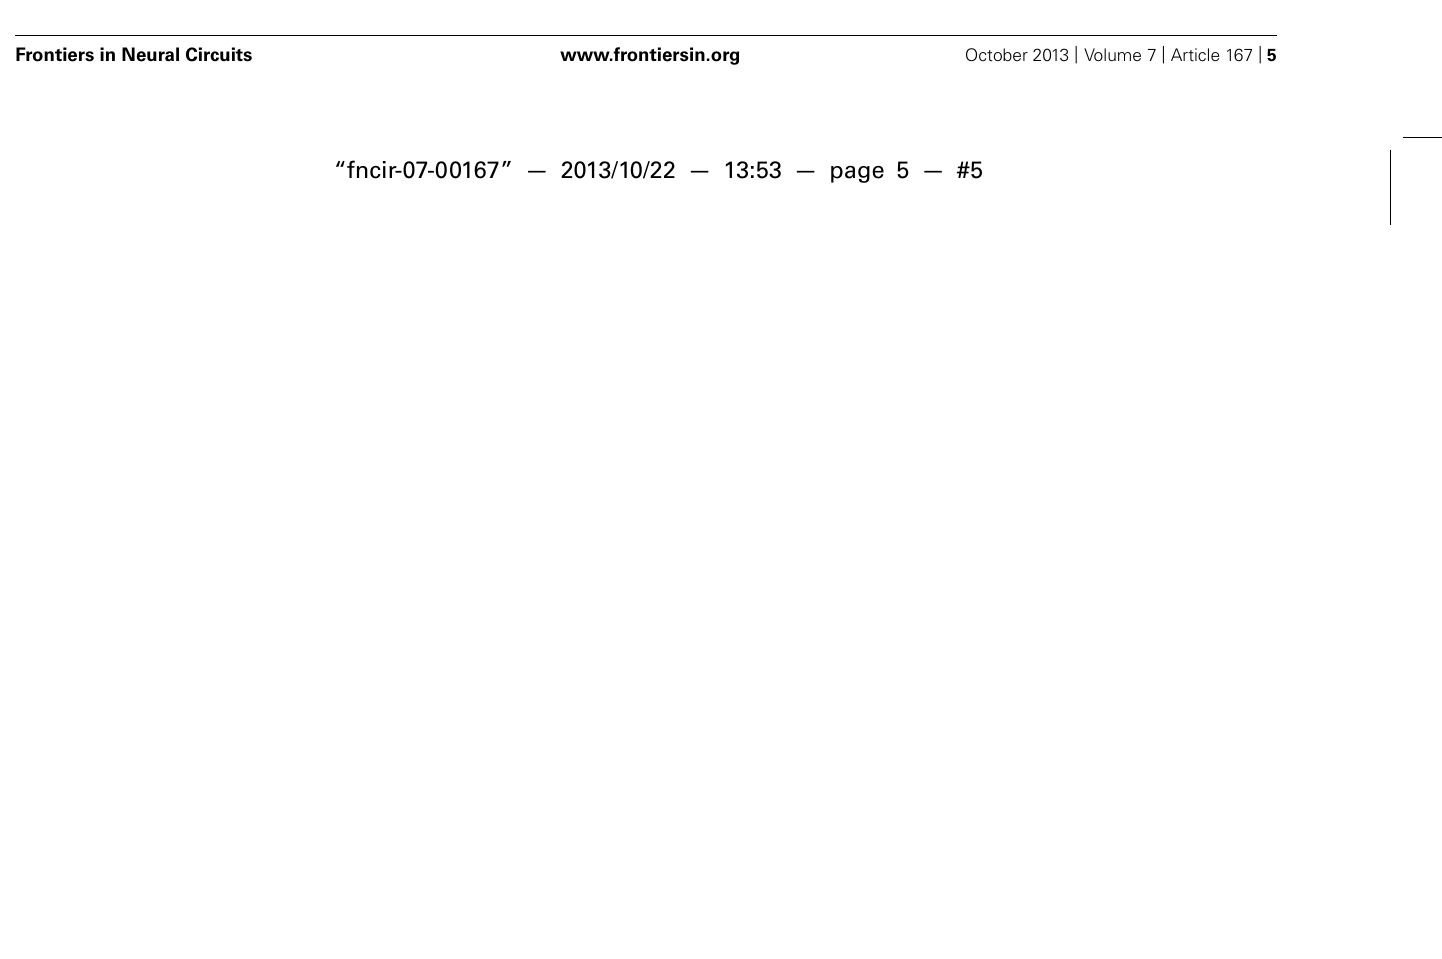
spontaneous activity in a network before stimulation across all 60 electrodes. Panel (E) presents evoked activity of the network during pulsed blue-light stimulation. The light blue color marks the duration of blue-light stimulation. Panel (F) present the electrode averaged normalized peri- stimulus time histogram (PSTH) for both pulsed (dark blue) and fade-in stimulation